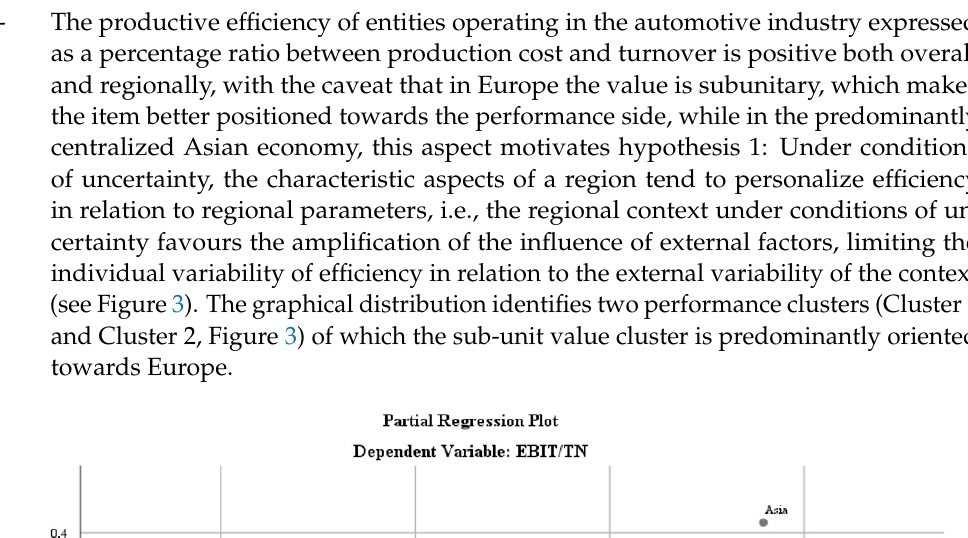
Figure 2. Distribution clusters of the predicted value of the overall financial performance model at the global level in the industry.